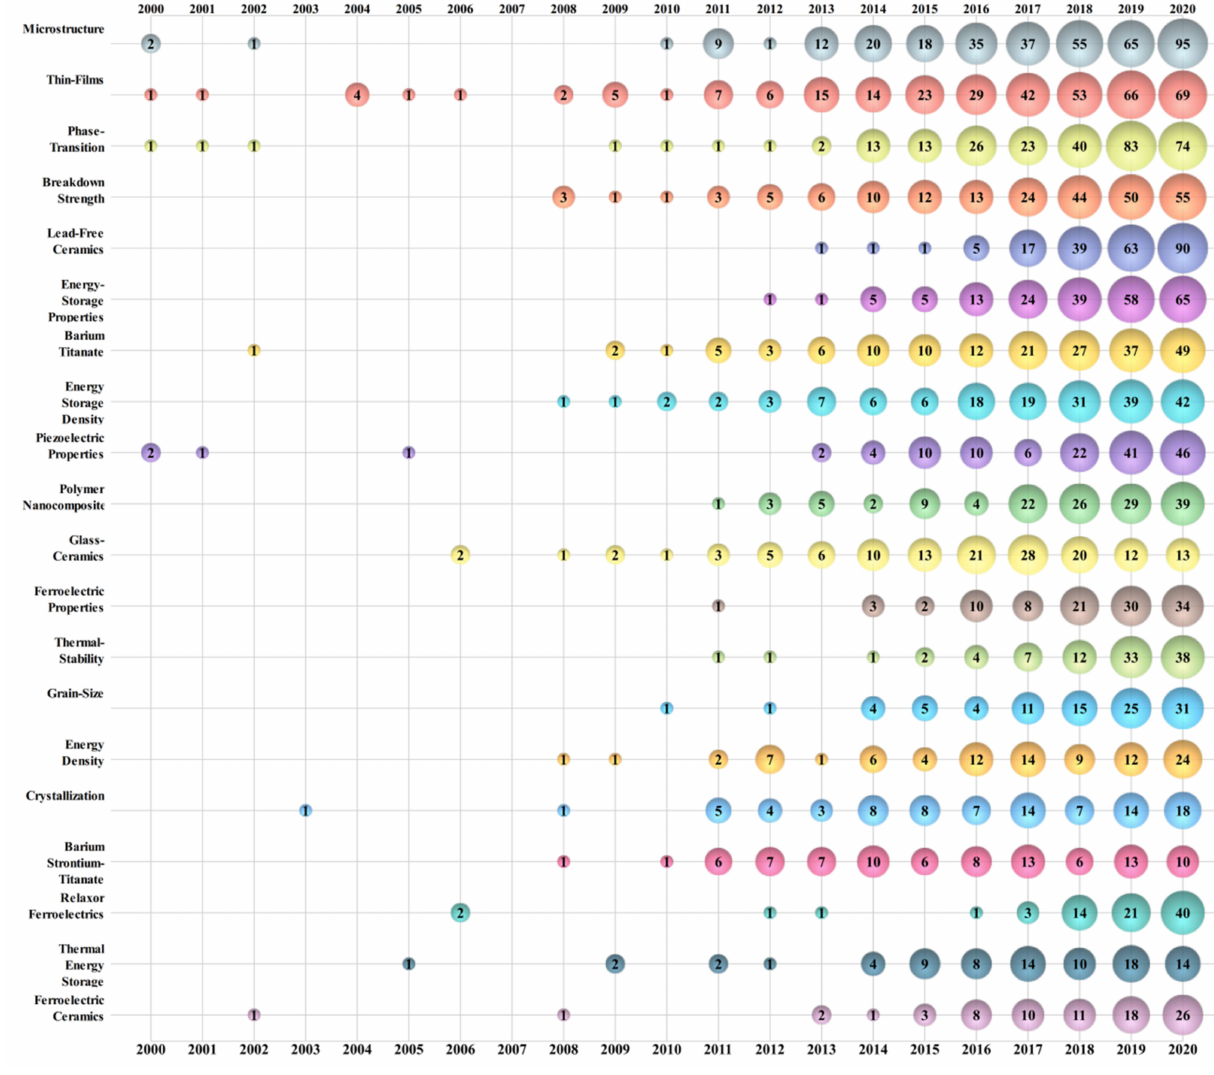
Figure 6. Bubble chart of top 30 keywords of energy storage ceramics research by